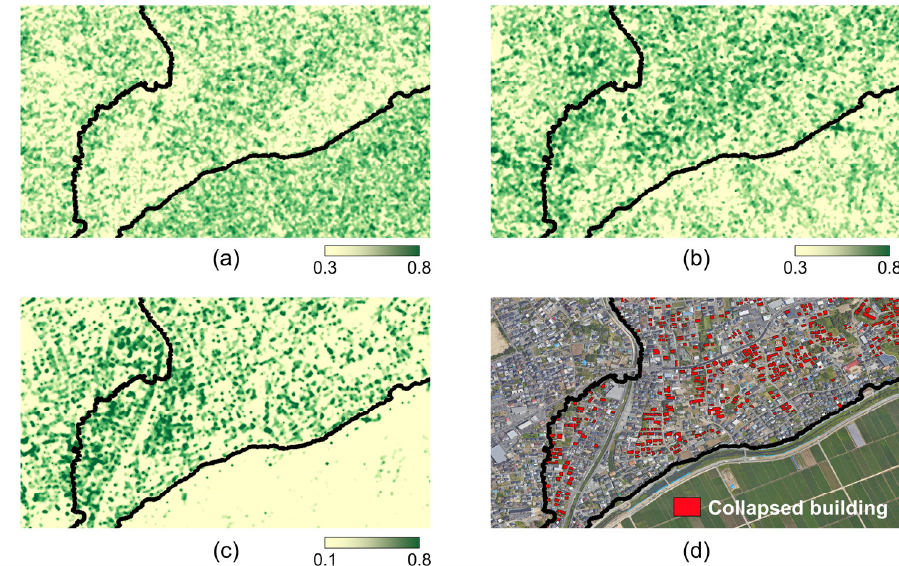
Figure 9. The Hamming distances calculated from different threshold constants of the local ternary codes: ( a ) no threshold (local binary codes), ( b ) speckle standard deviation (intensity standard deviation of the homogeneous area), and ( c ) three times greater than the speckle standard deviation. ( d ) The reference damage map.